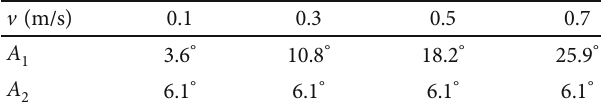
Table 1: Simulation results of walking with fi xed period.